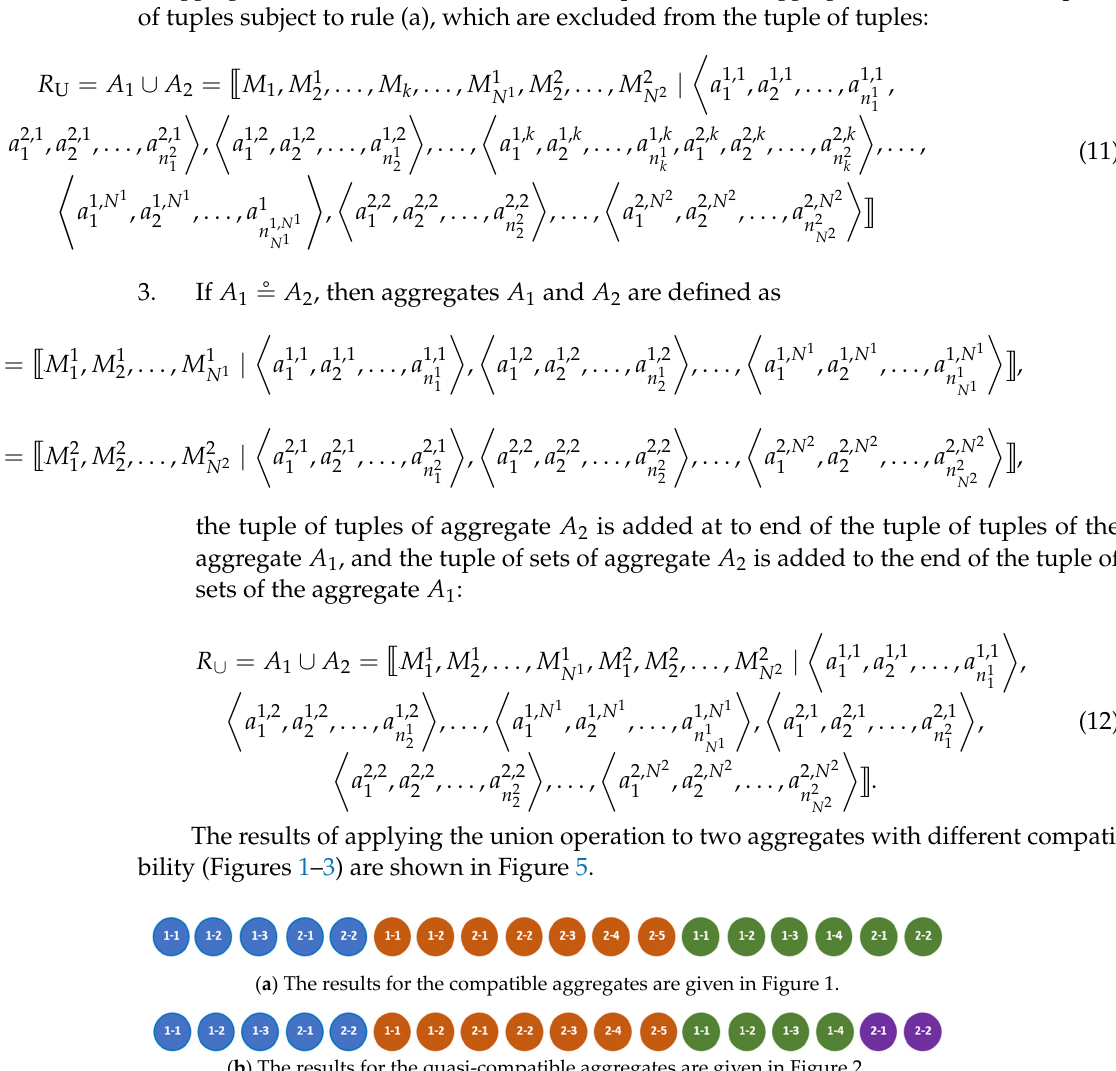
Figure 3. An example of two incompatible aggregates. Figure 4. An example of two hiddenly compatible aggregates.